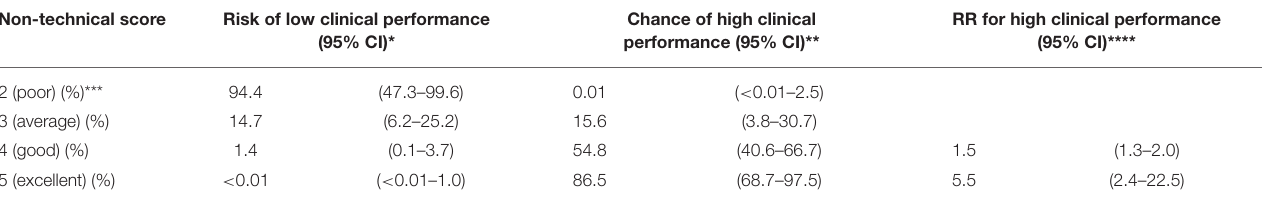
TABLE 2 | Chance of clinical performance according to the level of non-technical performance.